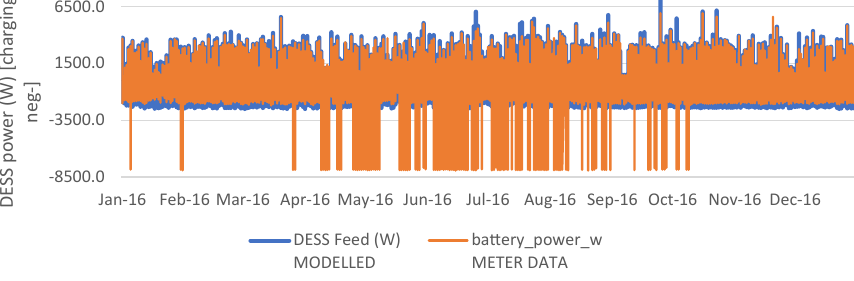
Fig. 5. Comparison of modelled vs. measured DESS power fl ows. Table 5. Ef fi ciency and effective ef fi ciency. Total supply from battery